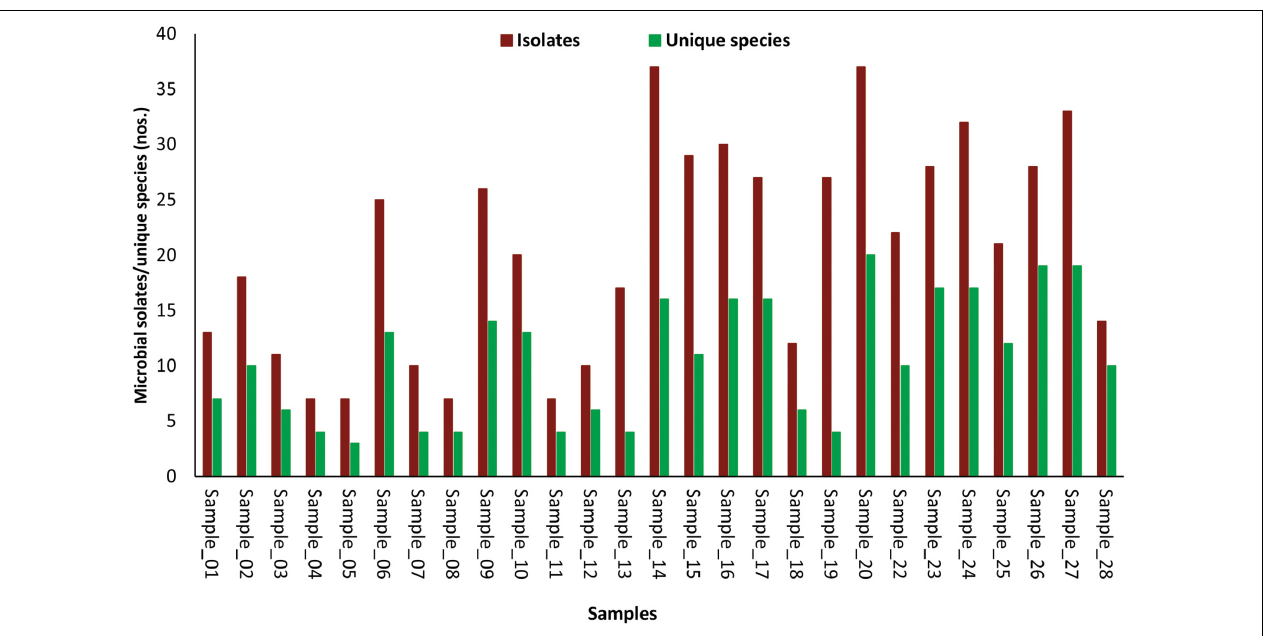
hominis (10%), Staphylococcus epidermidis (05%), Staphylococcus arlettae (05%), Bacillus subtilis (04%), Candida parapsilosis (04%), Pseudomonas stutzeri (04%), Staphylococcus gallinarum (03%), Staphylococcus haemolyticus (03%), and Staphylococcus warneri (03%), represented more than 50% of the total microbial diversity ( Figure 1B